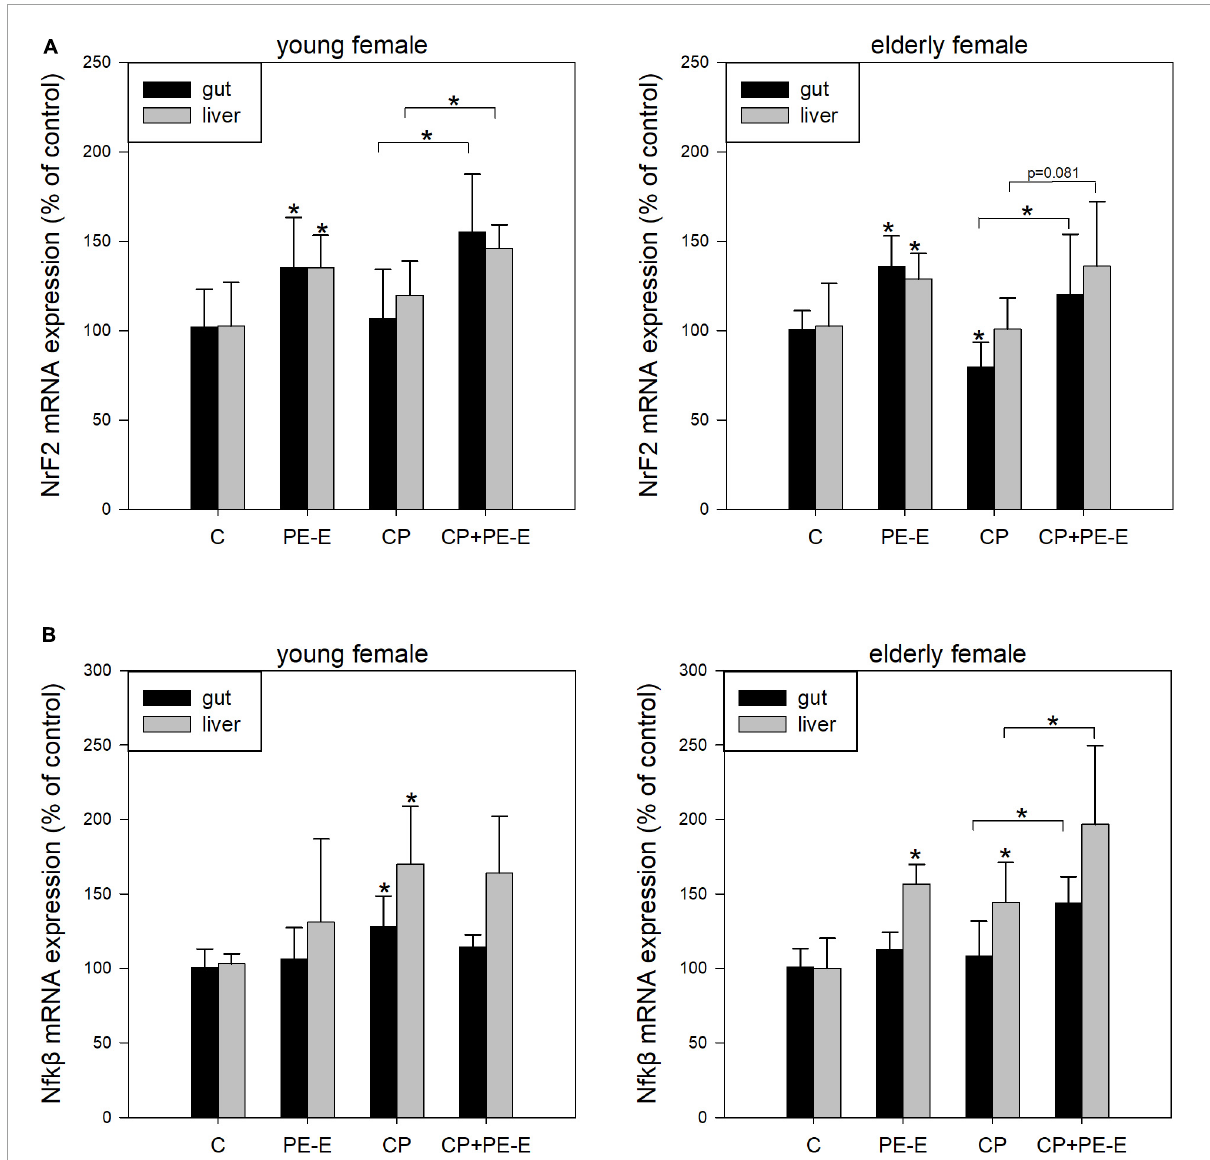
FIGURE3 mRNA expression levels of (A) NrF2 and (B) Nfk β in gut and liver tissues of young and elderly female mice. C, negative control group treated with water for 14 days; PE-E, Pleurotus eryngii control group treated with 600 mg/kg P. eryngii mushroom extract for 14 days; CP, positive control group treated with water for 14 days and 80 mg/kg cyclophosphamide the 14th day; CP+PE-E, administration of 600 mg/kg P. eryngii mushroom extract for 14 days and 80 mg/kg cyclophosphamide the 14th day. All values are expressed as the mean ± SD of six mice in each group. * p < 0.05 compared to control (water) ( t